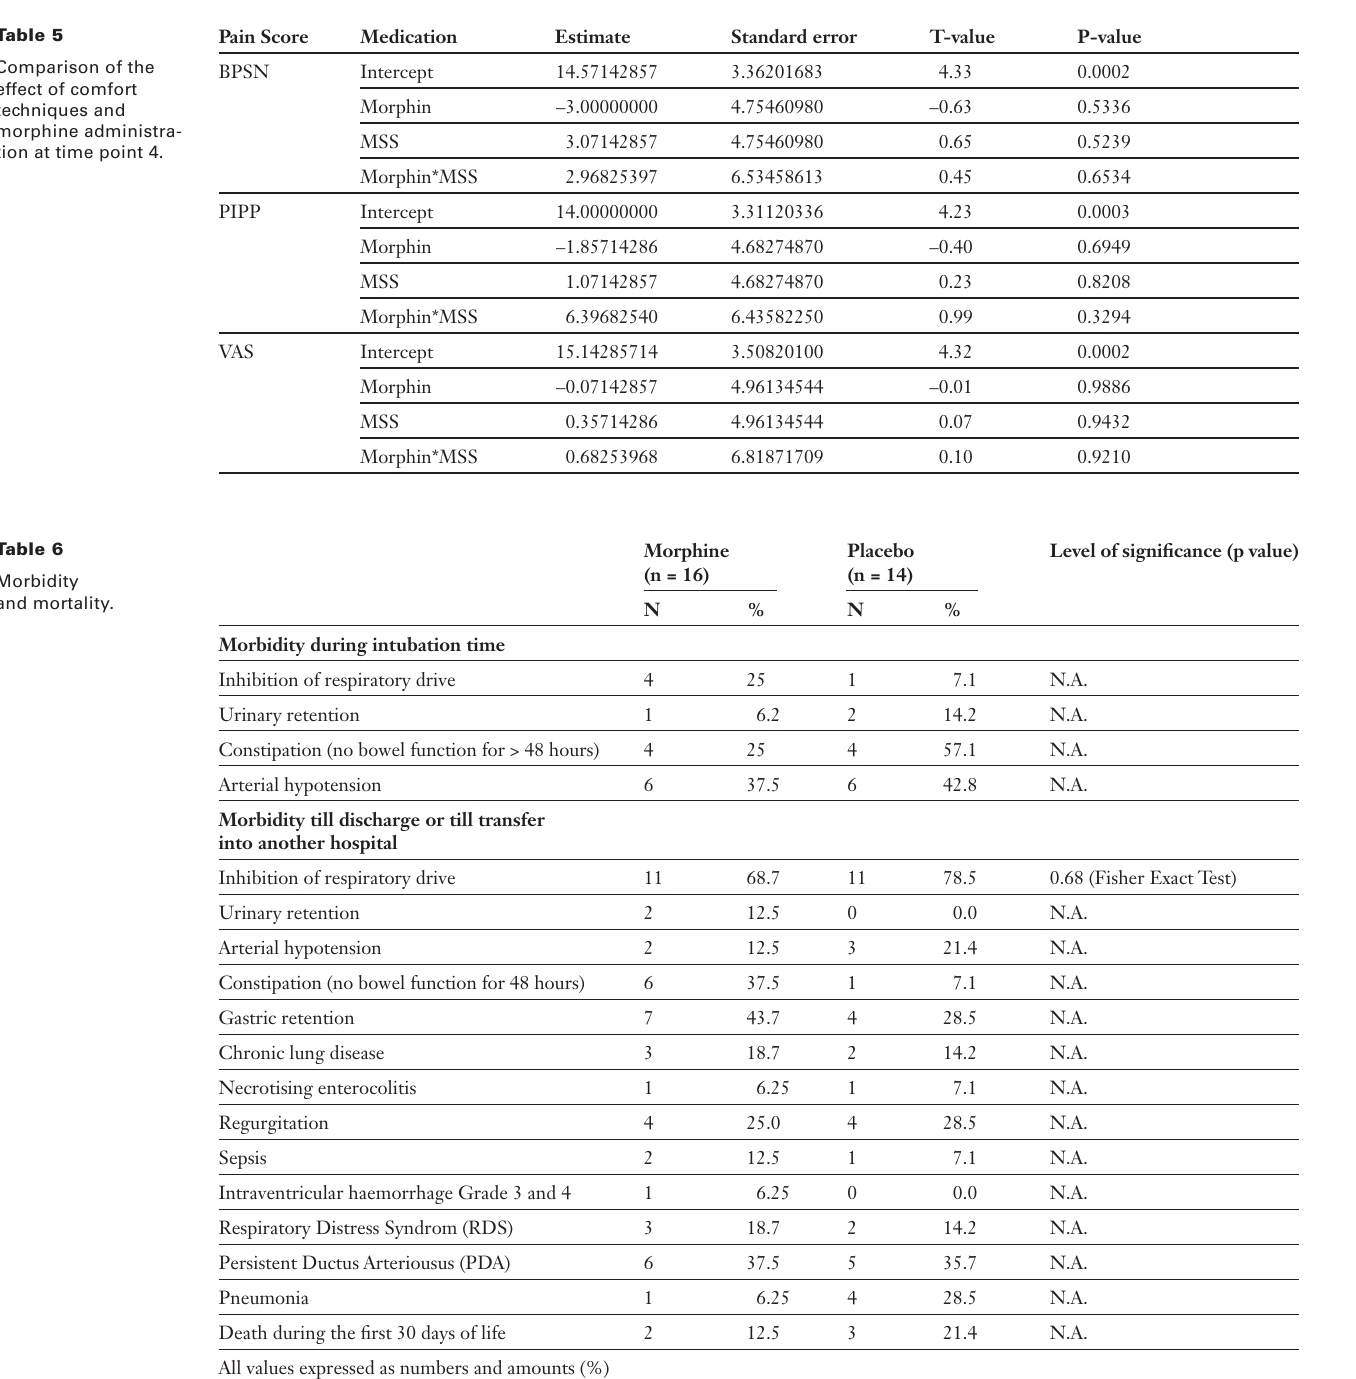
Comparison of the effect of comfort techniques and morphine administra- tion at time point